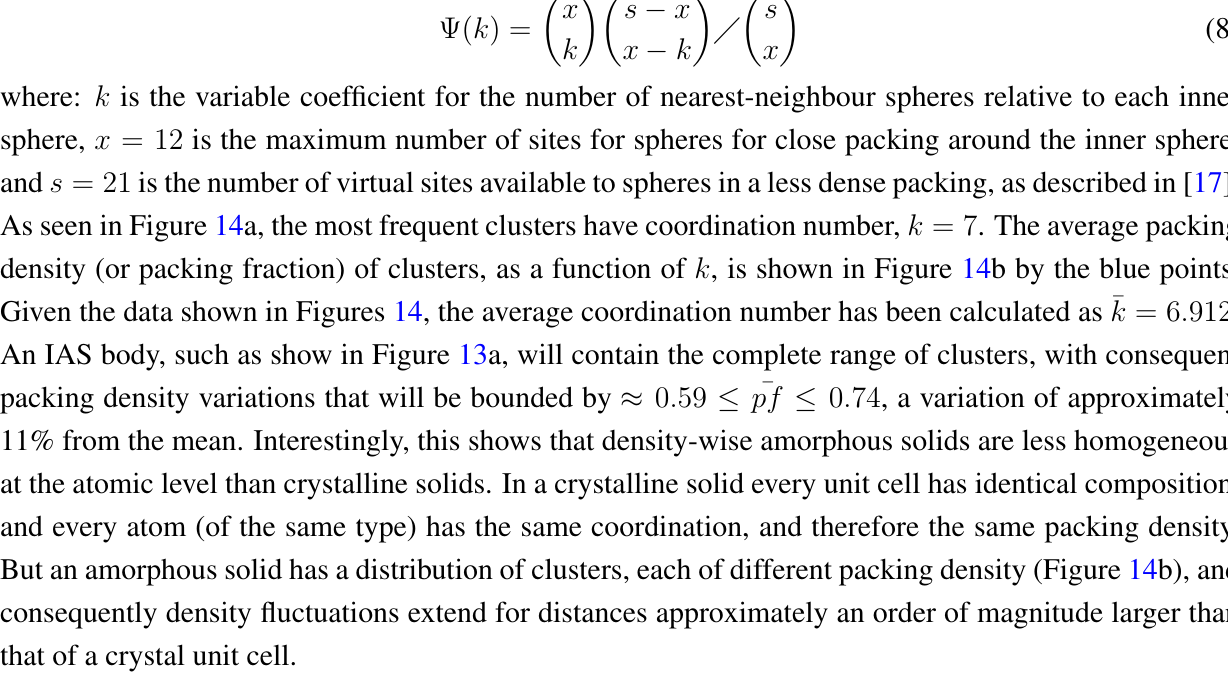
Figure 14. On left, probability of cluster coordination numbers in an IAS, based on Equation (8). On right, packing density of irregular clusters (in blue), and regular clusters (in red) as a function of coordination number, k . Monoatomic crystalline arrangement will have one coordination number only, an IAS will contain clusters with coordinations varying from 4 ≤ k ≤ 12